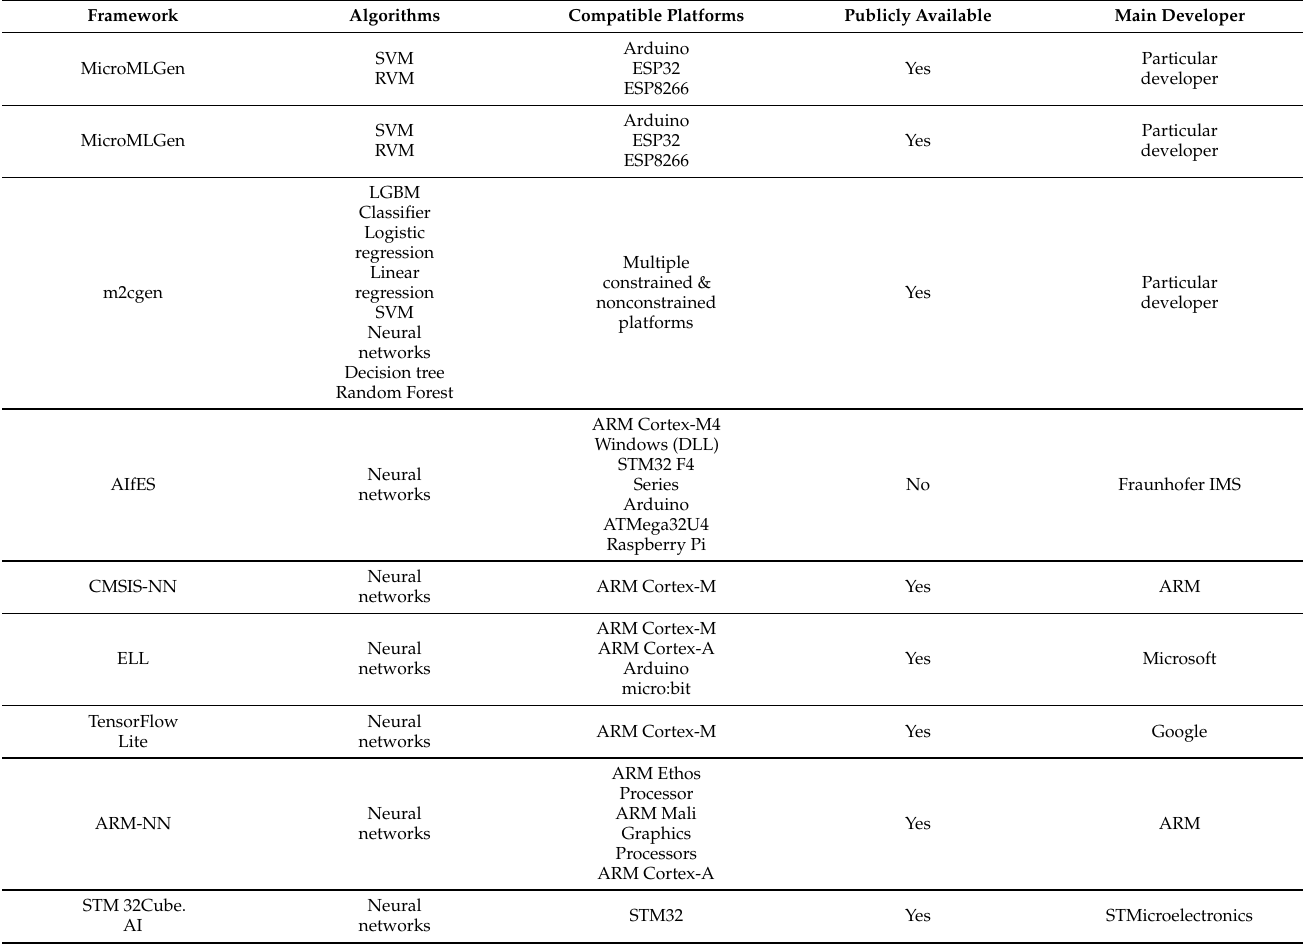
Table 5. TinyML Frameworks & Libraries